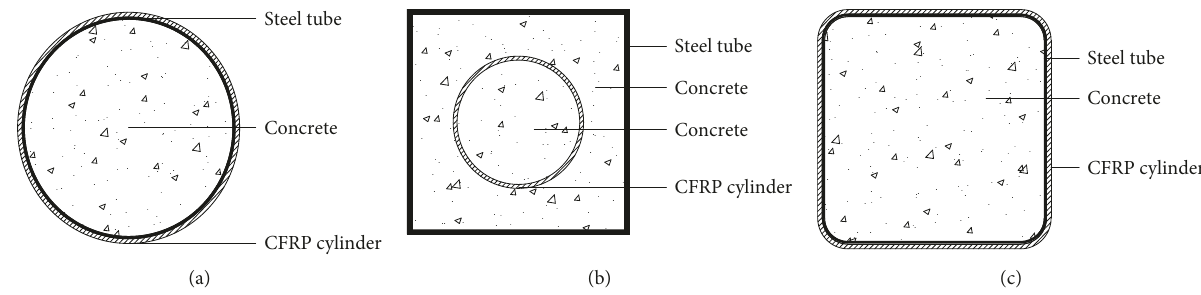
Figure 1: Cross section types of CFRP-confined CFSTcolumns. (a) Outer circular CFRP. (b) Inner circular CFRP. (c) Outer square CFRP.